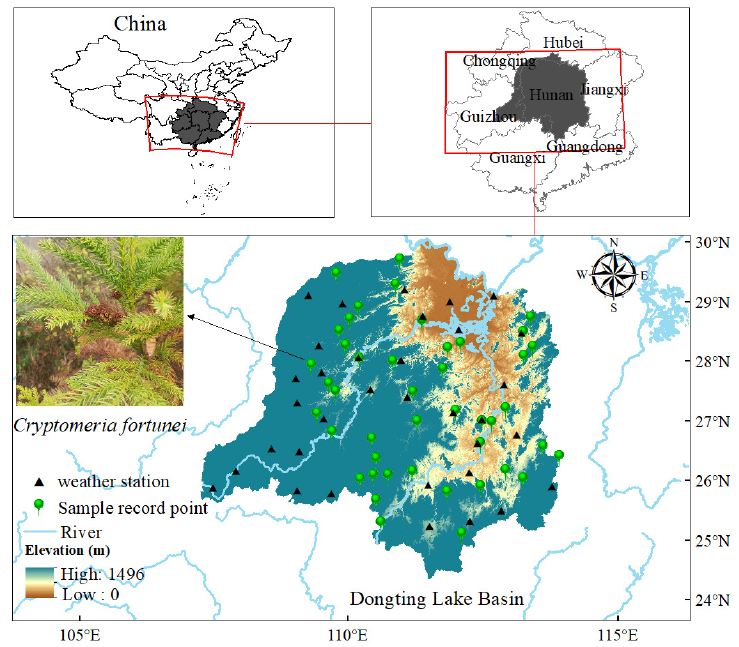
Figure 1. Location of the Dongting Lake watershed and distribution points of Cryptomeria fortunei.